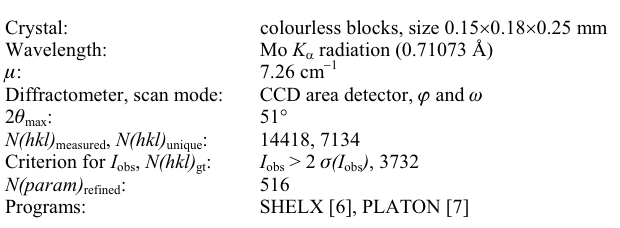
Table 1. Data collection and handling.